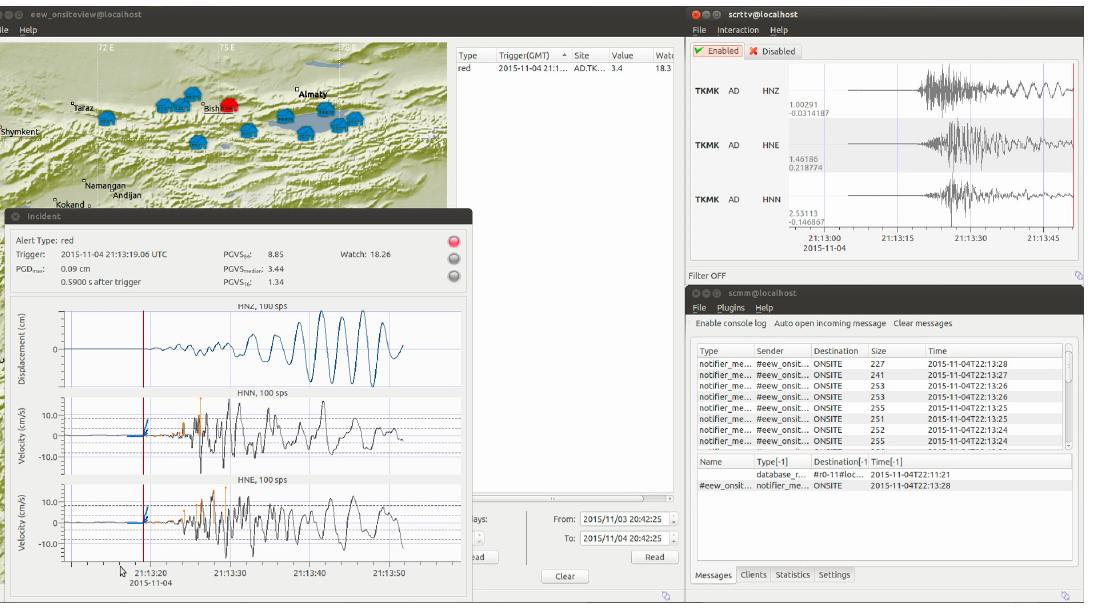
Figure 4. Example of output from the Seiscomp3 system implemented within the EEW software module of the MPwise, based on the GFZ-Sentry software developed at the GFZ [5–7] for the case of the Kyrgyz Republic. Note that this processing and associated images may be produced by a data center computer connected to the recording network, or on the touchscreen embedded in or connected to one of the units themselves (see Figure 1).